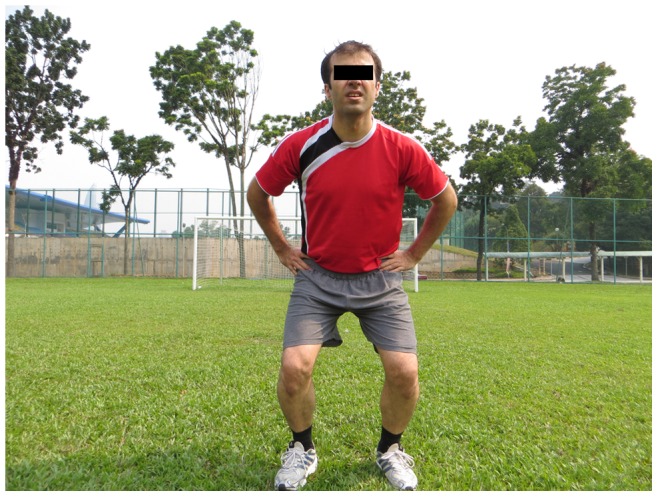
Double leg jump.